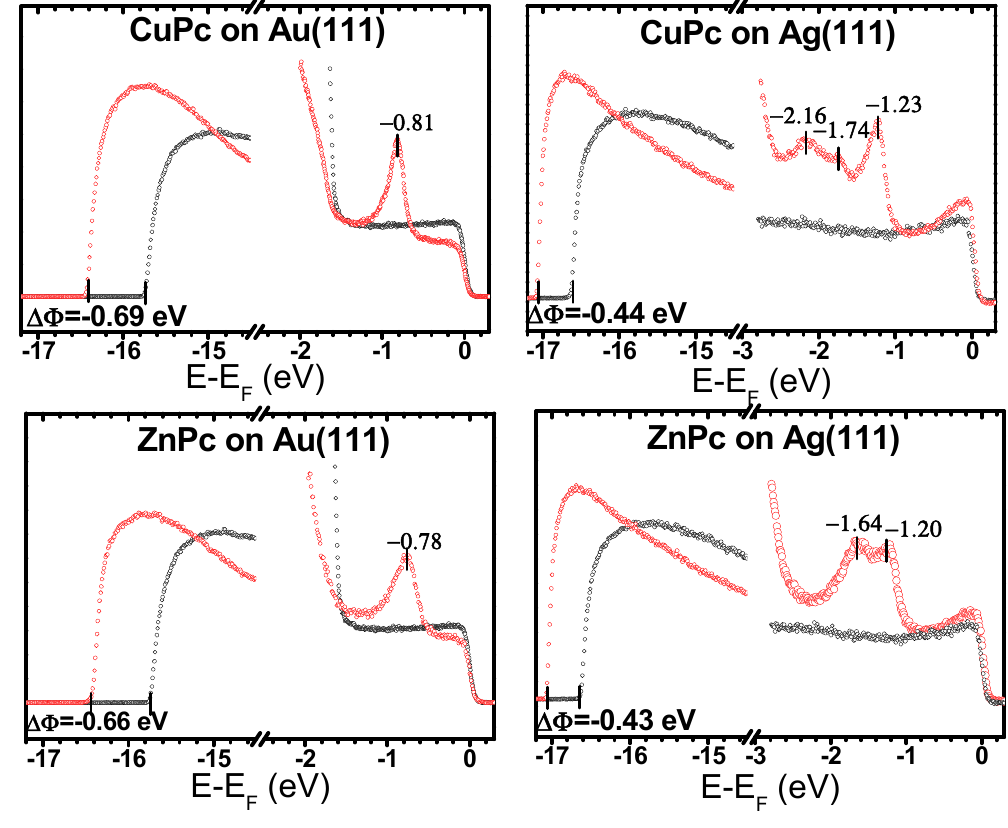
Figure 3. UPS spectra of monolayer CuPc on ( a ) Au(111) and ( b ) Ag(111), and ZnPc on ( c ) Au(111) and ( d ) Ag(111). In each panel, the secondary cutoff spectra are displayed at the left side, while the valence region is shown at the right side. The black curves represent the clean substrate, and the red ones correspond to the monolayer Pc films after annealing at 250 °C (for details see Section